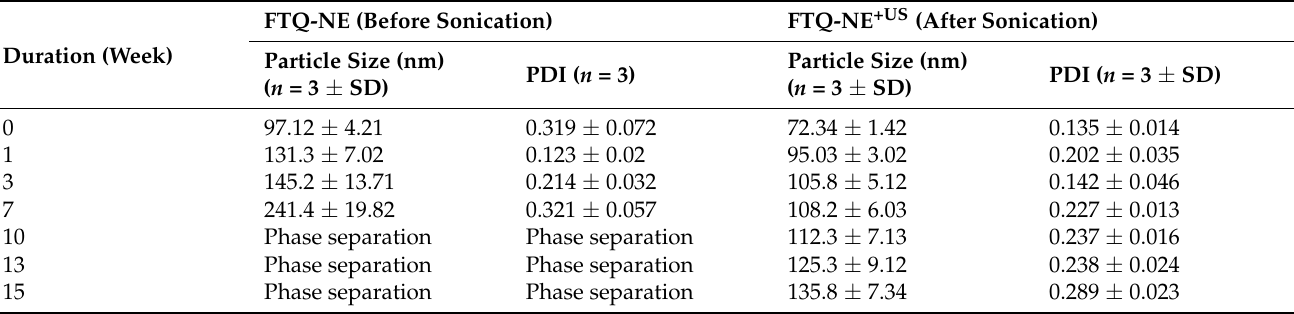
Table 7. Stability study of the optimized